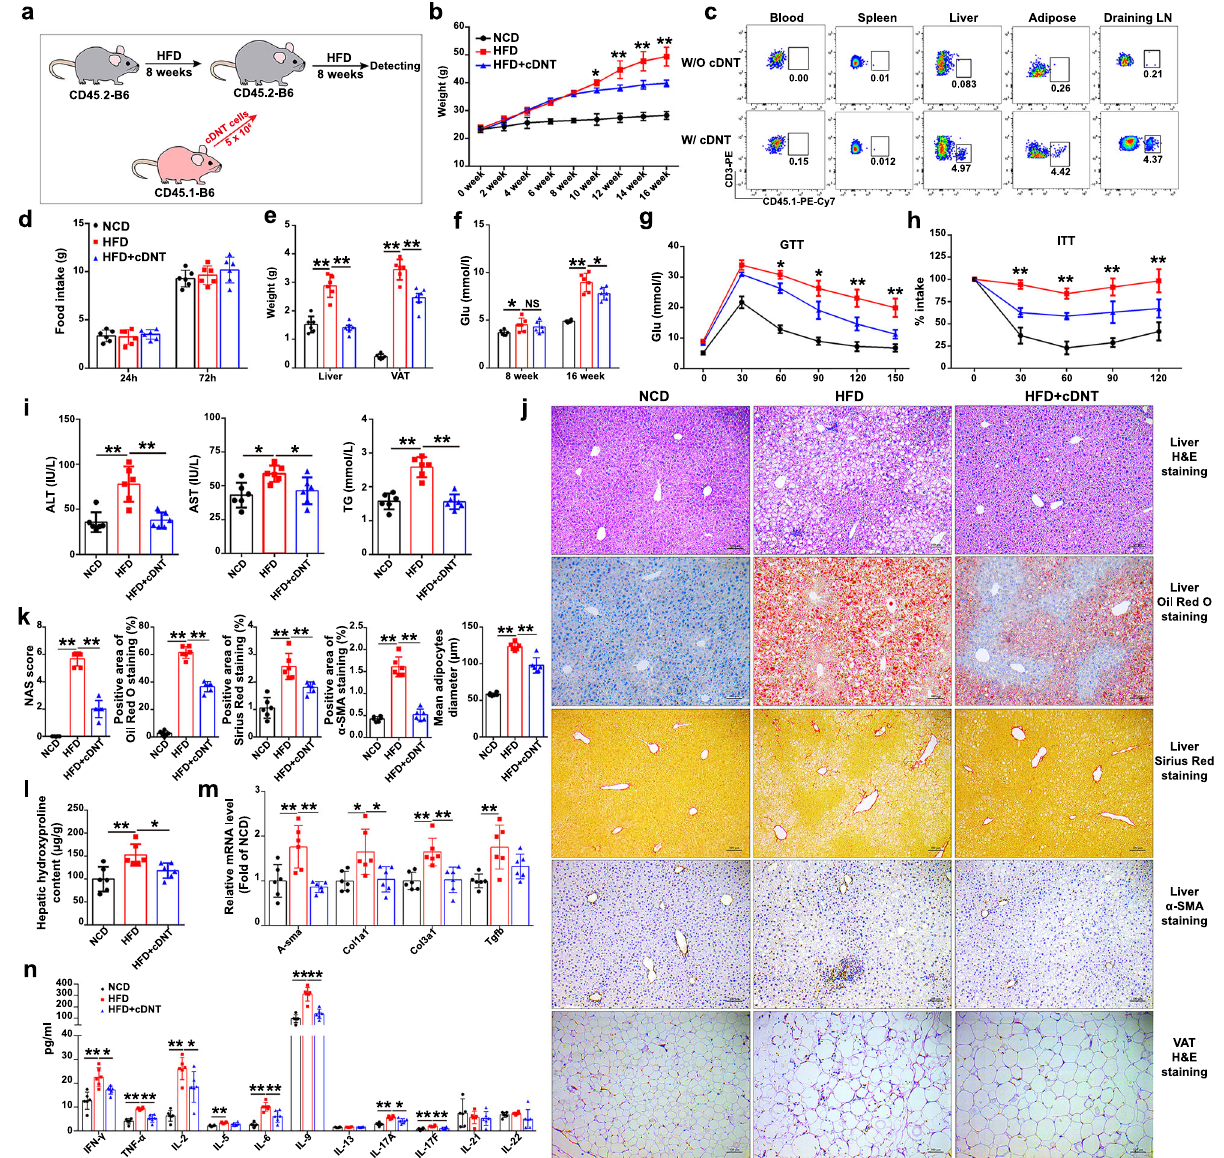
Fig. 1 Adoptive cDNT transfer alleviated obesity-induced insulin resistance and steatohepatitis in HFD-fed mice. a Flowchart of the adoptive transfer of cDNT. b Bodyweight of mice from each group. NCD, black; HFD, red; HFD + cDNT, blue. Actual p values (left → right): 0.012, 0.00027, 0.000038, 0.000005. c The in vivo distribution of transferred cDNT in mice. d Food intake by mice from each group. e Liver and VAT weights of mice fed the NCD or HFD for 16 weeks. Actual p values (left → right): 0.000004, 0.000001, 0.000004, 0.000001. f Fasting plasma glucose levels were measured in mice fed the HFD for 8 or 16 weeks. Actual p values (left → right): 0.048, 0.78, 9.69e − 8, 0.025. g , h GTTs and ITTs were performed after intraperitoneal glucose or insulin injection. Actual p values (left → right): g 0.037, 0.015, 0.0041, 0.0031; h 8.58e − 8, 2.74e − 7, 0.000029, 0.000097. i Plasma ALT, AST, and TG levels were measured. Actual p values (left → right): 0.00030, 0.00049, 0.015, 0.045, 0.000013, 0.000011. j Representative H&E staining, oil red o staining, Sirius red staining, α -SMA staining in liver paraf fi n sections, and H&E staining in VAT paraf fi n sections. Scale bars, 100 μ m ( n = 6 biologically independent samples per group). k Quanti fi cation of liver and VAT histology staining. Actual p values (left → right): 0.00065, 0.00028, 5.80e − 9, 1.22e − 8, 0.000010, 0.0074, 8.30e − 9, 1.42e − 8, 5.93e − 9, 0.000029. l Hydroxyproline levels in liver tissues of each group. Actual p values (left → right): 0.0032, 0.048. m Fibrosis-related genes in liver tissues. Actual p values (left → right): 0.0052, 0.0014, 0.017, 0.024, 0.0021, 0.0030, 0.0040. n Plasma cytokines of mice in each group. Actual p values (left → right): 0.00027, 0.029, 0.000002, 0.000055, 0.000009, 0.035, 0.00069, 0.000009, 0.0049, 0.000003, 0.000036, 0.000039, 0.010, 0.00014, 0.0018. Data are presented as the mean ±SD; n = 6 mice/group. Statistical analysis for the fi rst left fi gure in k (NAS score group) was performed by Kruskal – Wallis multiple comparisons test, and others were performed by one-way ANOVA with post hoc multiple comparisons test. Two-sided p values < 0.05 were considered signi fi cant. * p < 0.05; ** p < 0.01. Source data, including exact p values, are provided as a Source data fi